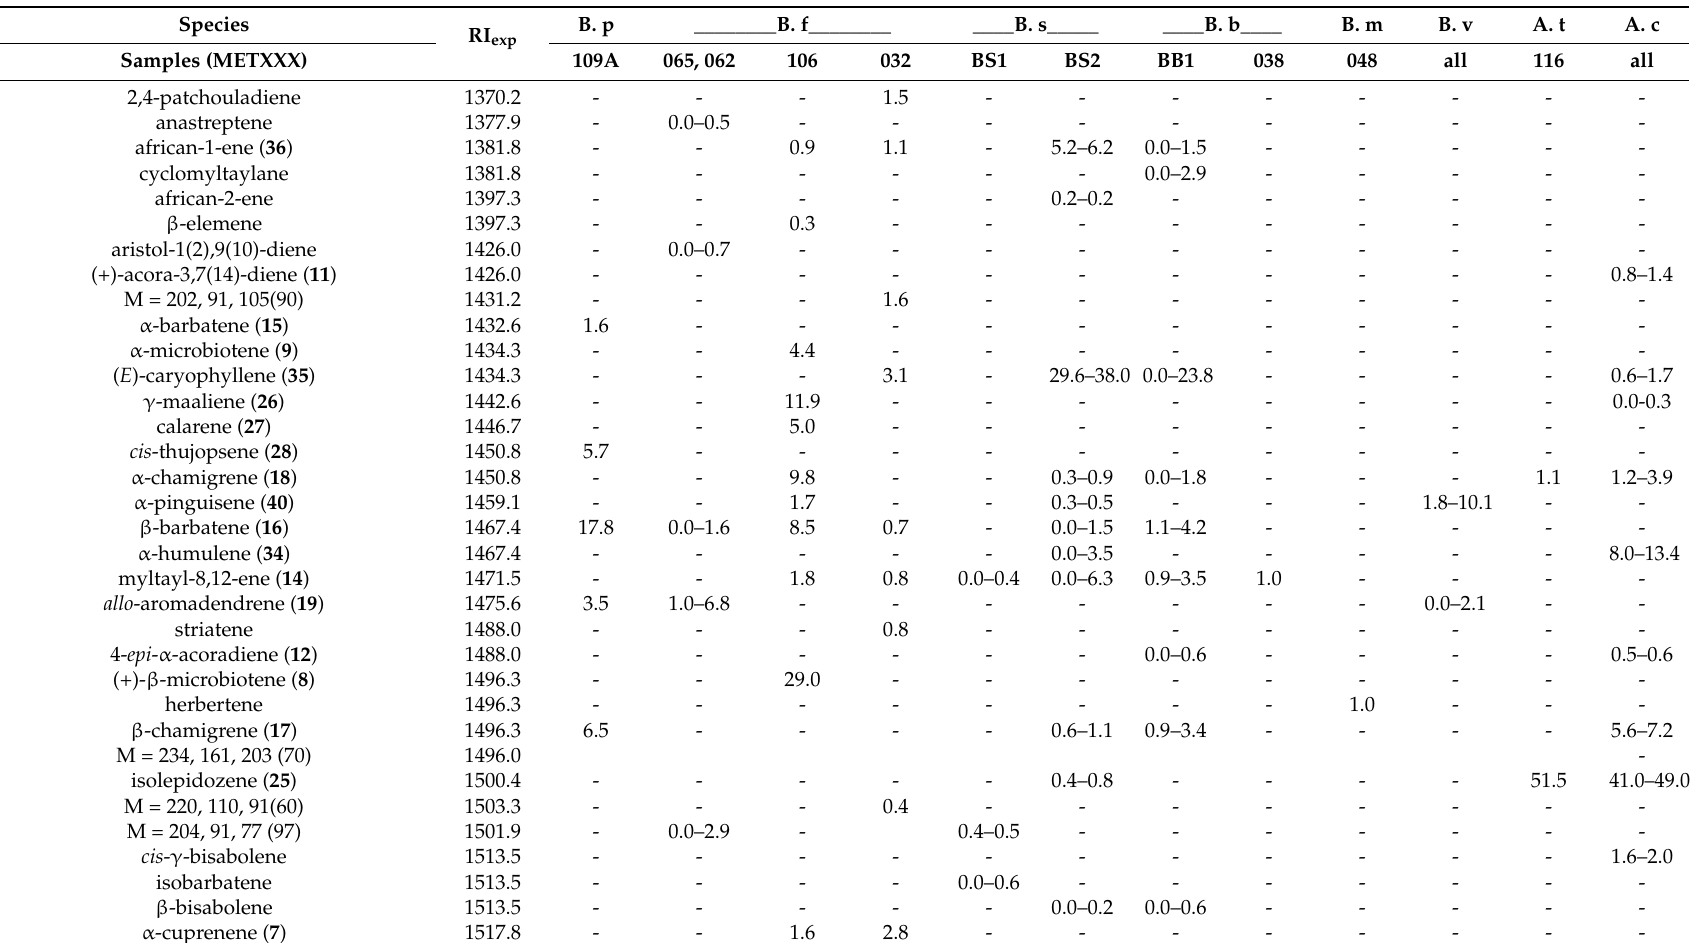
Table 8. Sesquiterpene composition (relative percentage, %) of the analyzed